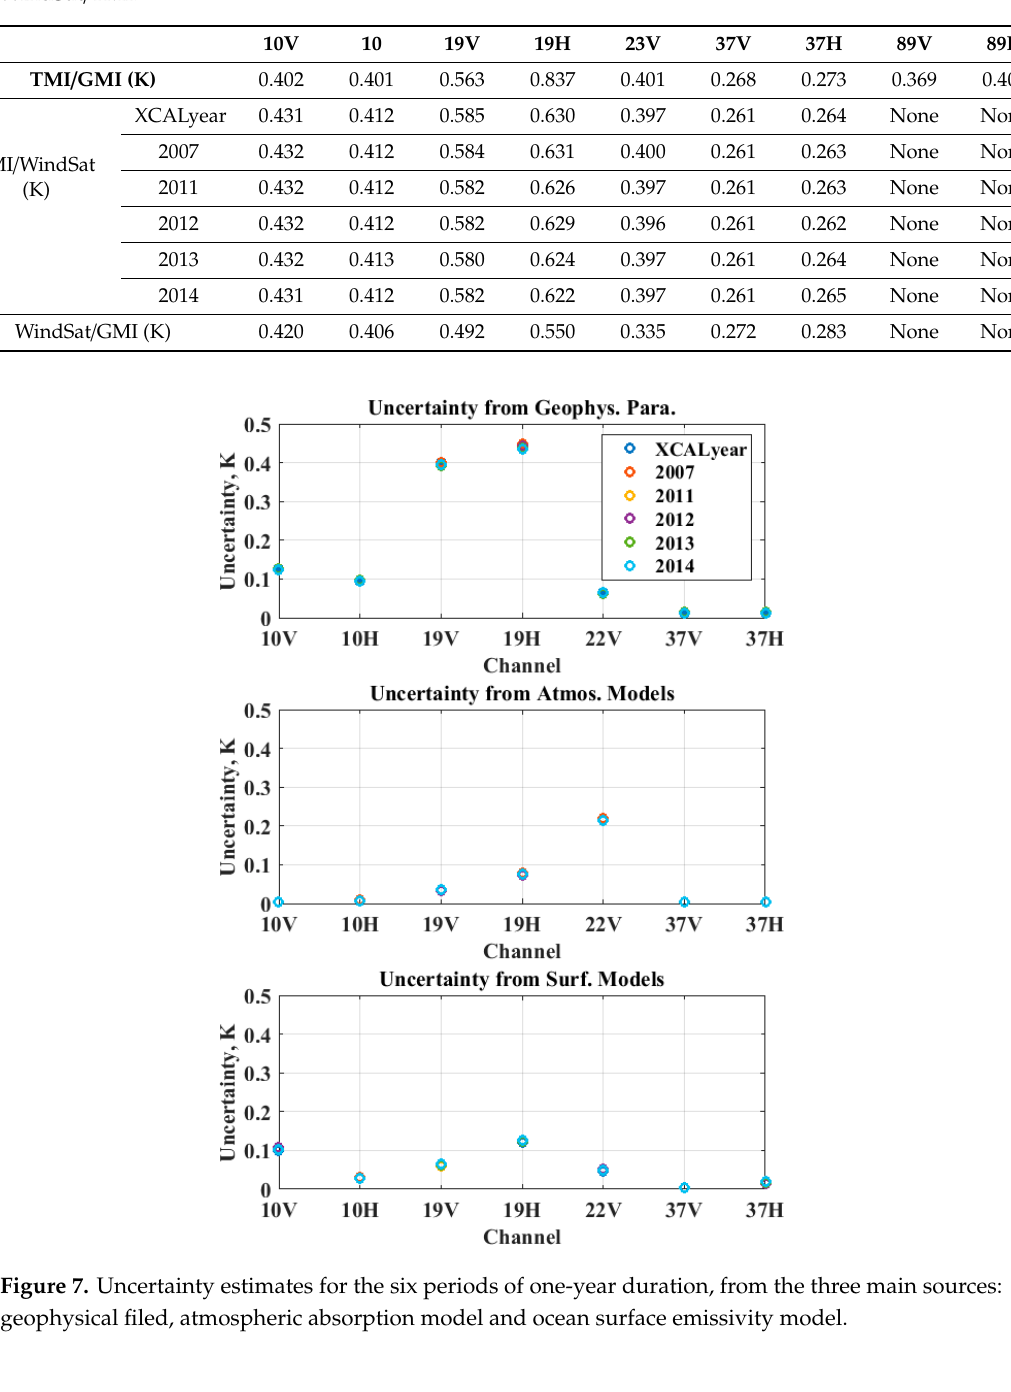
Table 8. Combined standard uncertainties for intercalibration of TMI / GMI, TMI / WindSat, and WindSat / TMI.